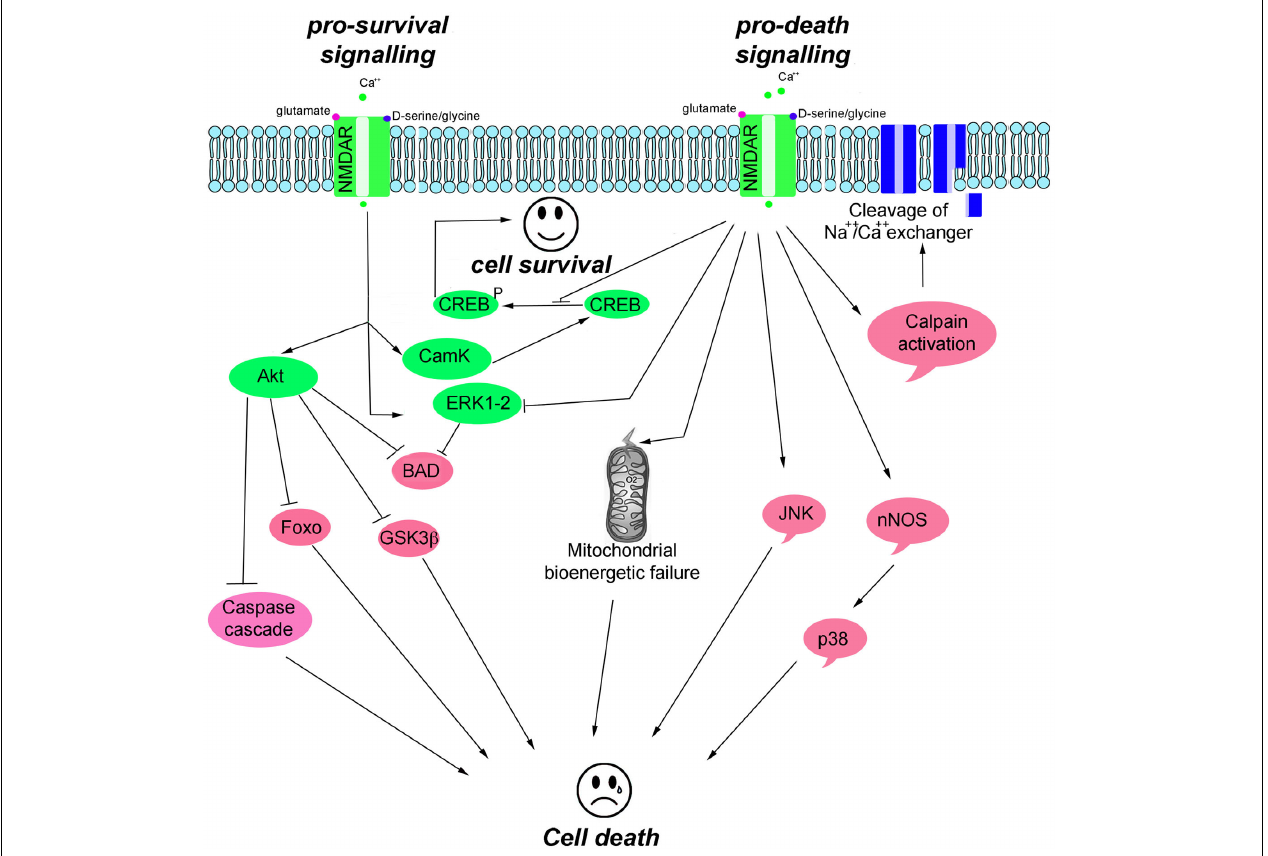
FIGURE 2 | Scheme illustrating the main pro-survival and pro-death signals triggered by NMDAR activity.